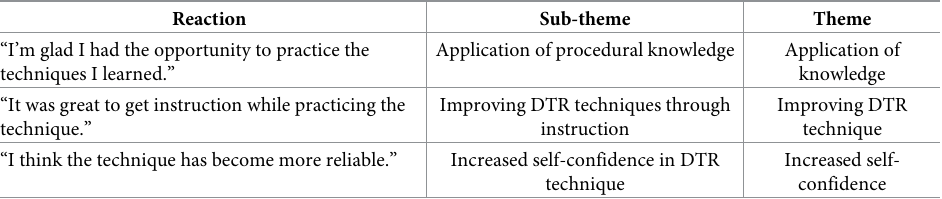
Table 4. Content analysis of post-practice FGI � in the intervention group (7 groups, n = 39).